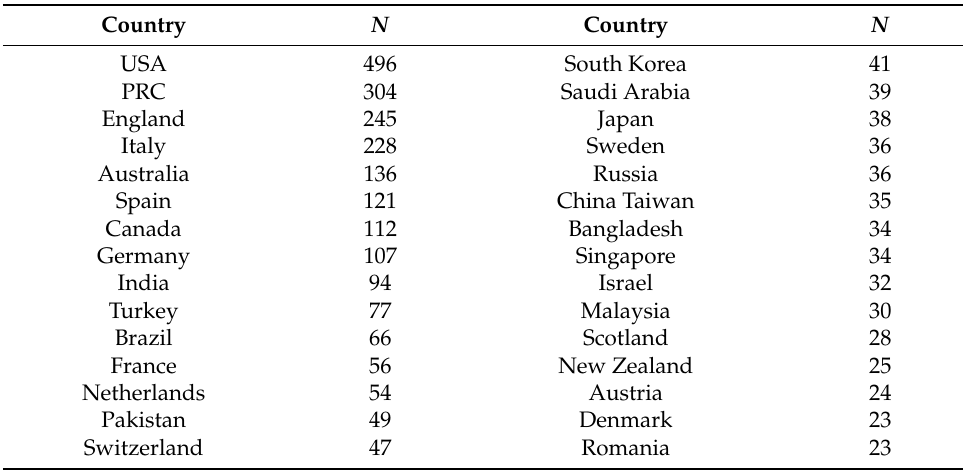
Figure 3. Network map of institution collaboration visualization. Table 5. Countries and regions publishing at least 20